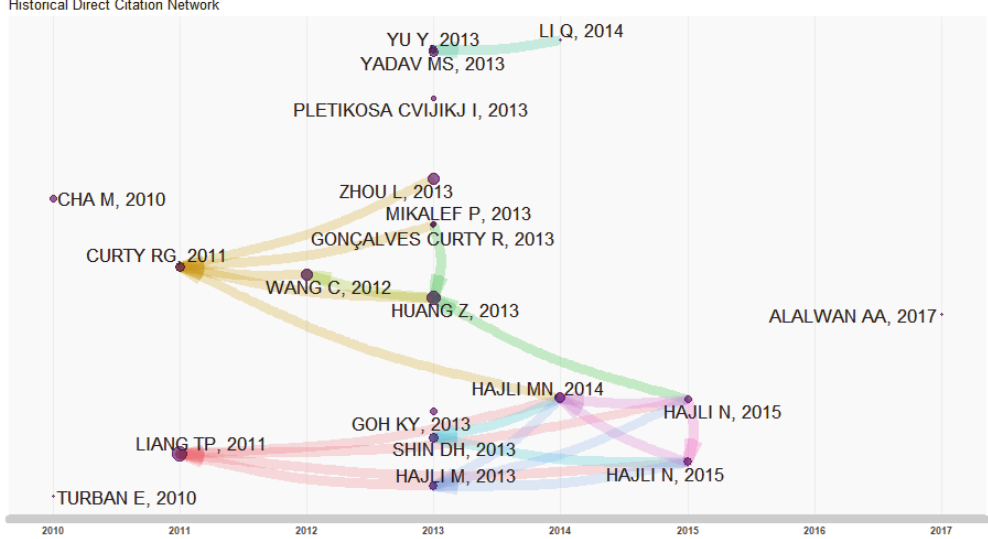
Fig. 8. Historical direct citation